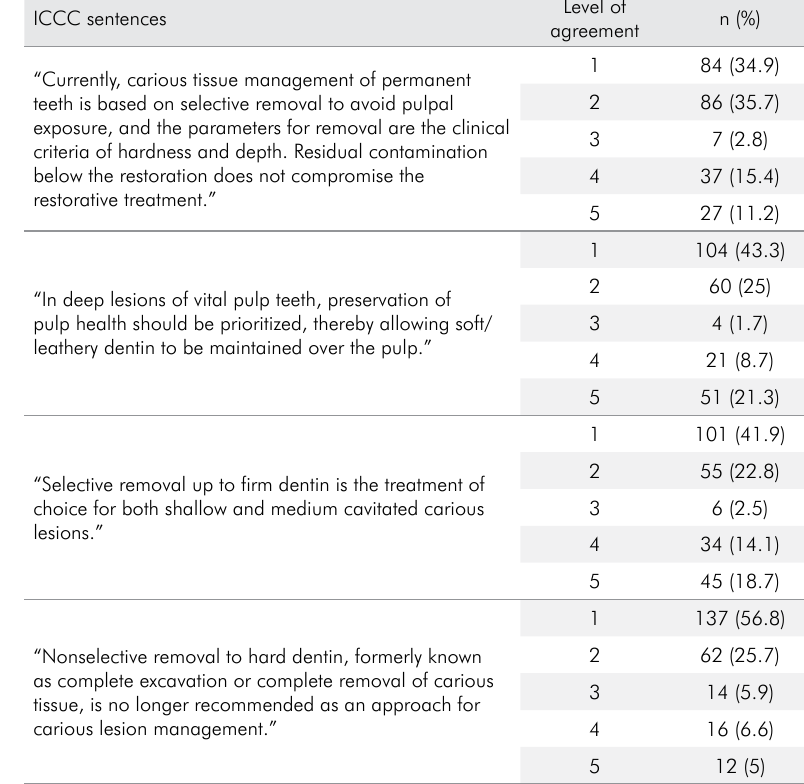
Table 3. ICCC sentences and level of agreement (1 - totally disagree, 2 - partially disagree, 3 - do not know, 4 - partially agree, 5 - totally